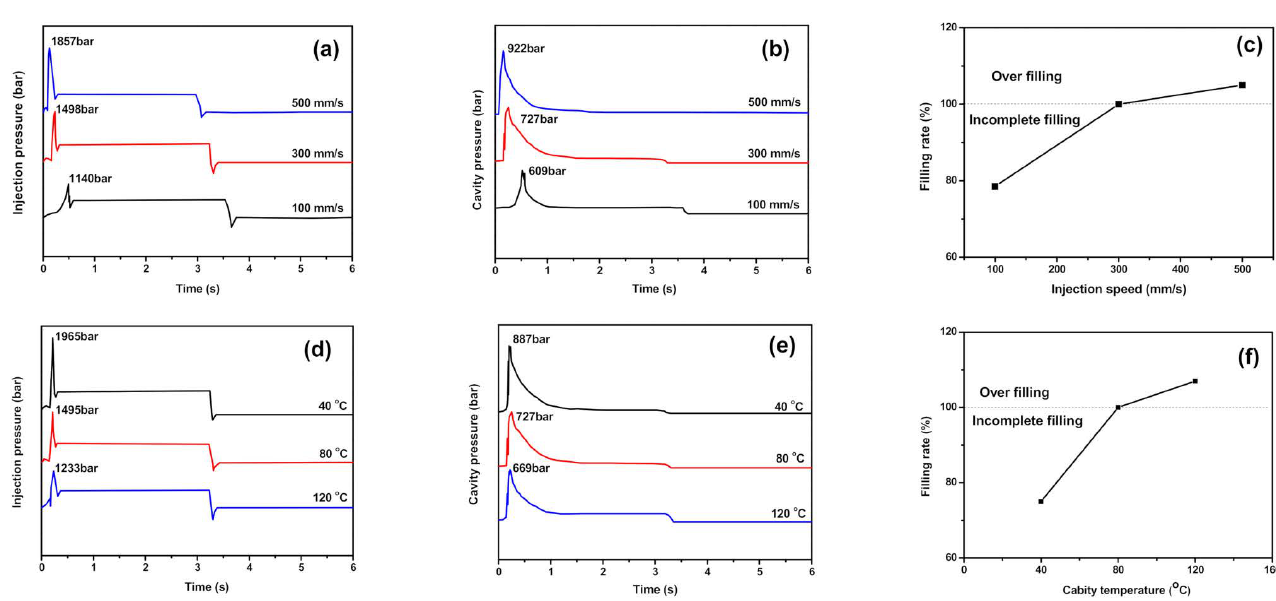
Figure 3. Injection pressure and cavity pressure vs. time of PVDF/GP composites with 1 wt% GP during the micro-injection molding process at different injection speed ( a – c ) and cavity temperature ( d – f